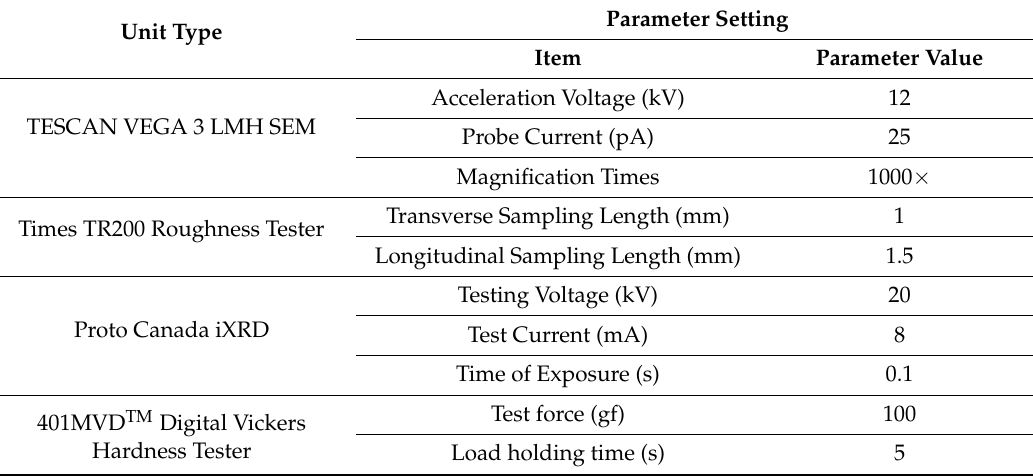
Table 4. Parameter settings of the main testing